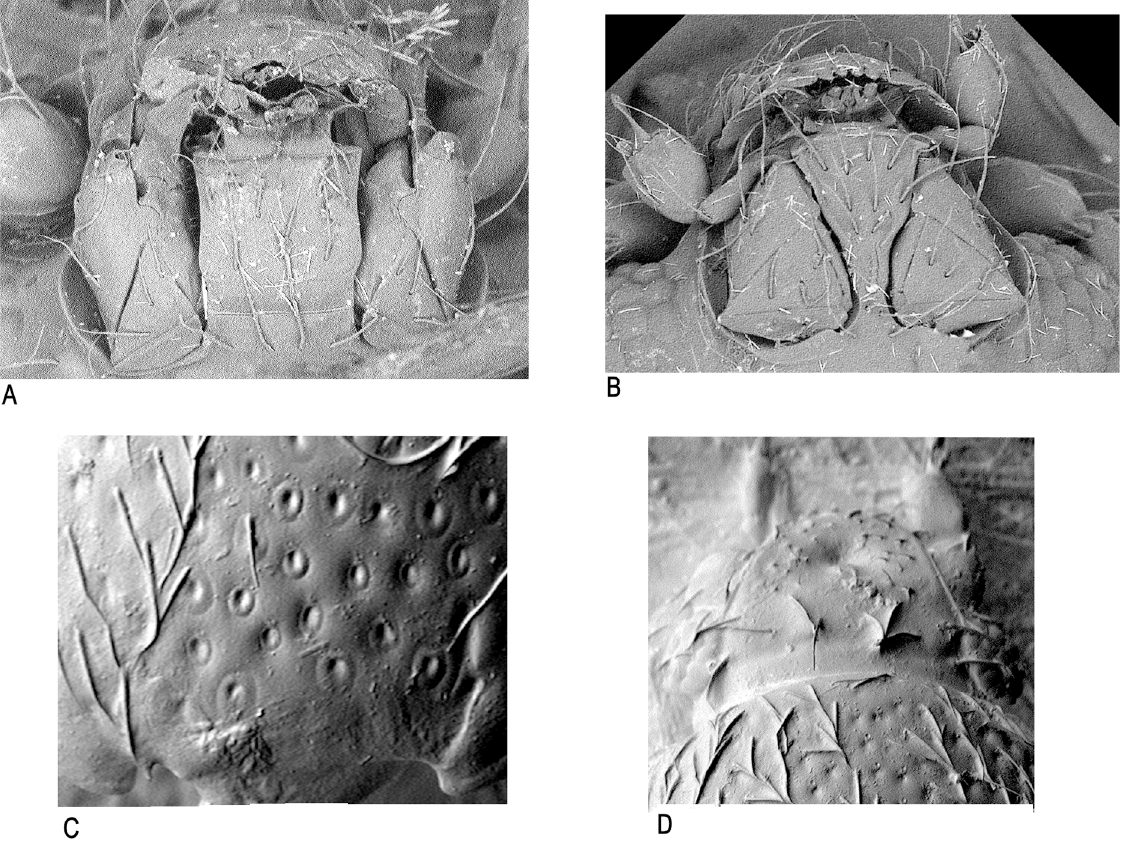
Fig. 9. Cissidium spp., menta. A . C. globulum sp. nov. ×1400. B . C. triangulum sp. nov. ×1200. C . Indeterminate Cissidium showing foveolae on pronotum ×1400. D . Indeterminate Cissidium showing fovea on head